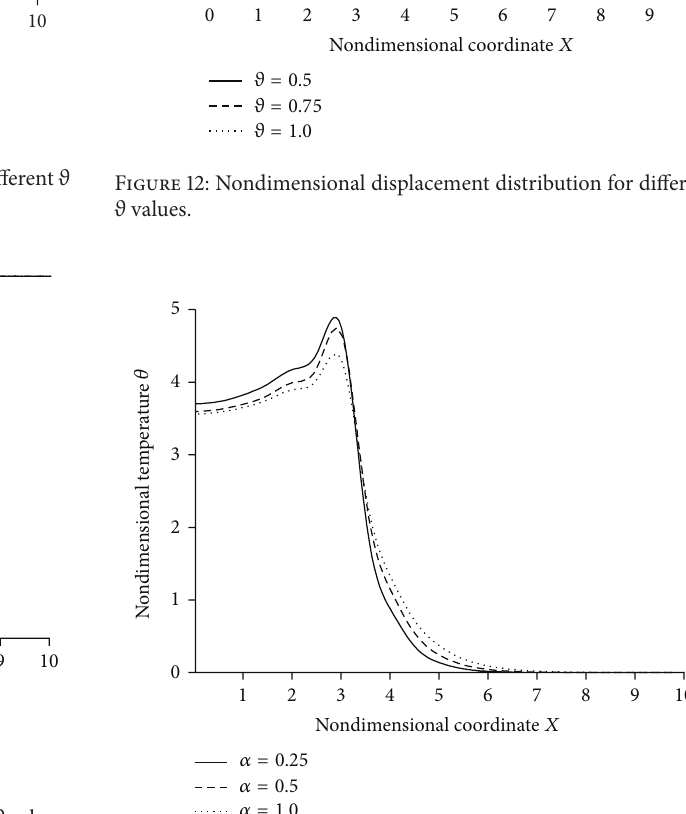
Figure 11: Nondimensional stress distribution for different 𝜗 values.